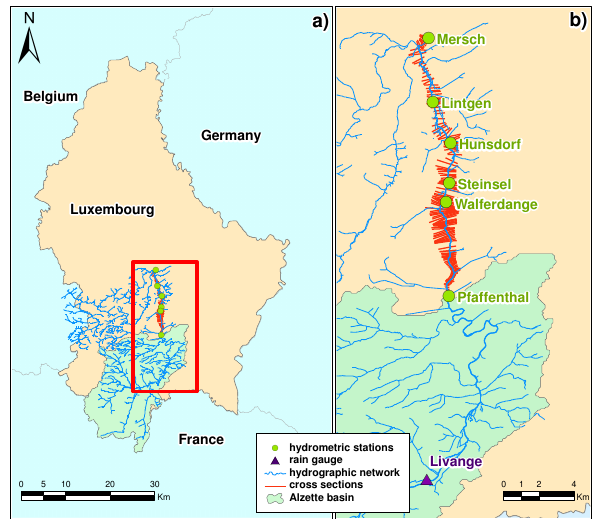
Fig. 1. Study site in the Alzette River basin showing: (a) the drainage area down to Pfaffenthal and the 19km river reach whose geometry is represented by the cross sections, (b) the hydrometric stations along the river.